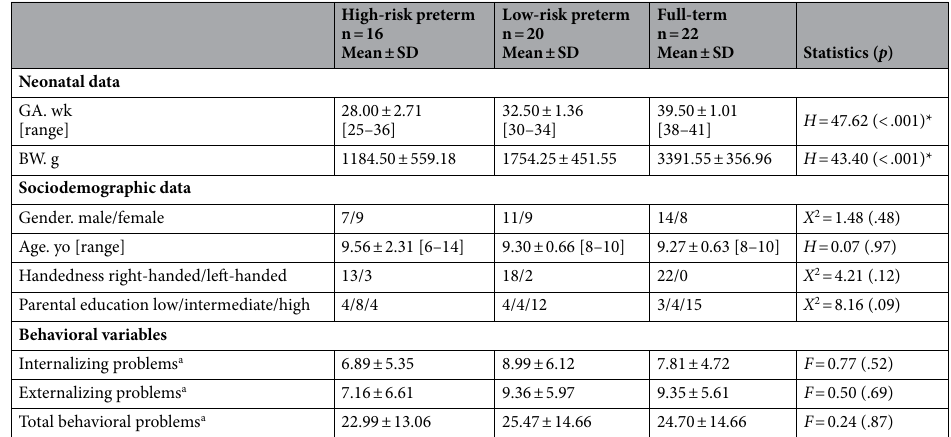
Table 2. Neonatal, sociodemographic and emotional-behavioral variables. SD: standard deviation; GA: gestational age; wk: weeks; BW: birth weight; g: grams; yo: years; K : Kruskal–Wallis test; X 2 : Chi-square test; and F : Snedecor’s F distribution. *Statistically significant differences between High-risk preterm < Low-risk preterm < Full-term. a Available data for internalizing problems, externalizing problems and total problems: 16 GM-IVH-preterm, 20 low-risk preterm and 21 term